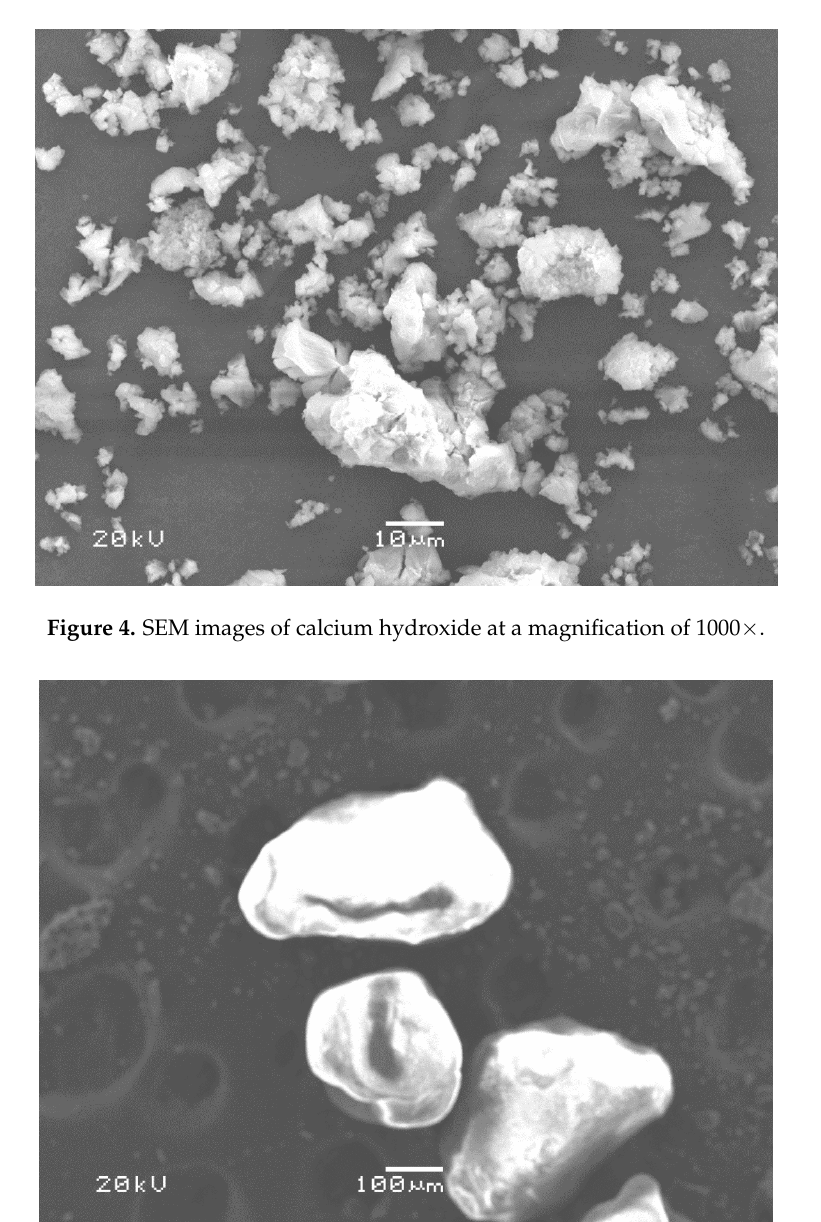
Figure 5. SEM images of inert sand samples used at magnification of 100×.